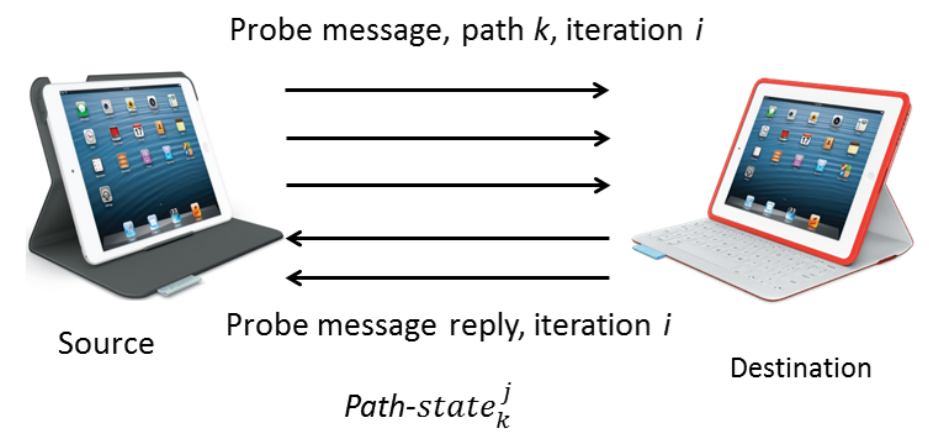
Figure 3. PM and PMR